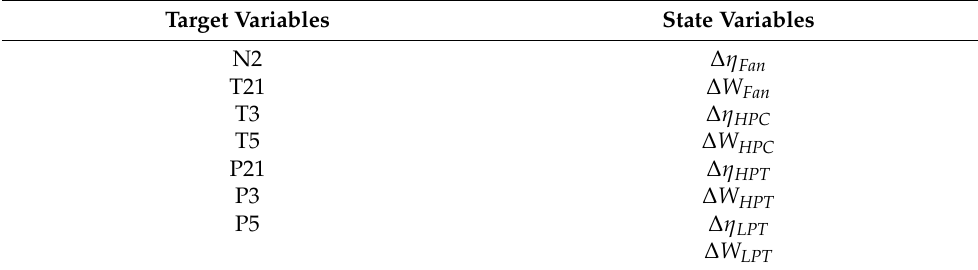
Table A3. Underdetermined solver, full sensor suite.